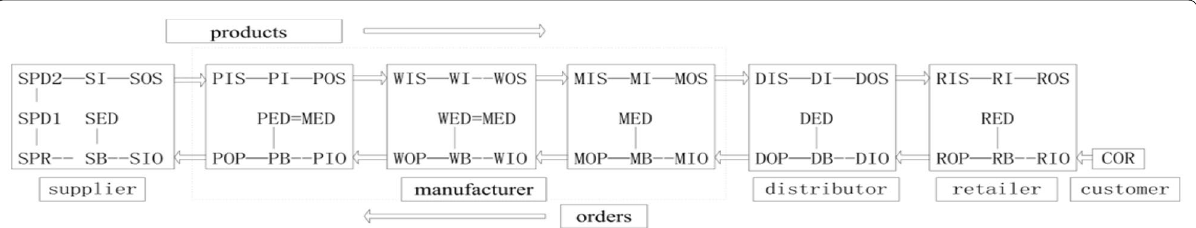
Figure 2 Structural model of the supply chain system denoted by state variables at nodes